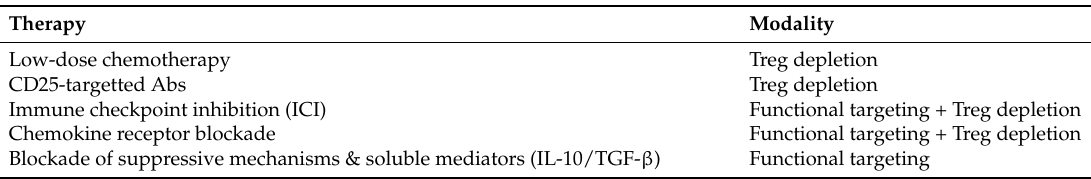
Table 1. Therapeutic modalities for targeting Tregs (reviewed in